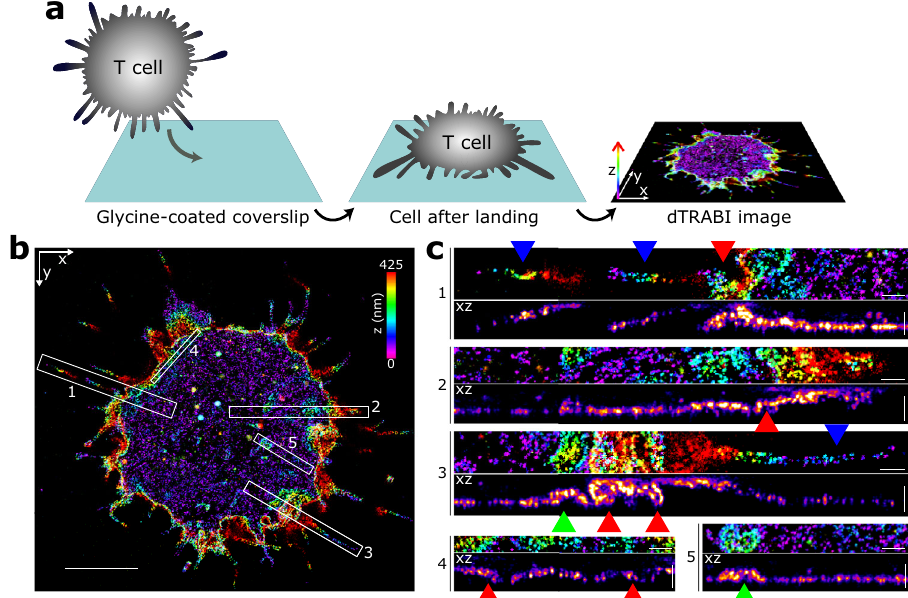
Fig. 4 Cell surface receptor nanotopography visualized by 3D TRABI imaging. a Schematic illustration of sample preparation for a receptor nanotopography imaging using dTRABI. A cell in suspension is fi rst immobilized on a glycine-coated coverslip, fi xed and imaged using dTRABI approach. The resulting three-dimensional dTRABI image represents a footprint of a cell on the optical surface with the color-coded axial position of localizations (right panel). b Three-dimensional dTRABI image of T-cell surface receptor CD45 with selected ROIs exhibiting a broad z -distribution of receptor localizations. CD45 was labeled with Alexa Fluor 647-conjugated primary antibody (MEM-28). c Magni fi ed x – y and x – z projections of ROIs 1 – 5 as in b . Blue arrowheads point to microscopic membrane protrusions at the cell edges, red arrowheads to folded nanoscopic protrusions under the cell body and green arrowhead to membrane invagination. Scale bars, 5 μ m in b and 500 nm in c .